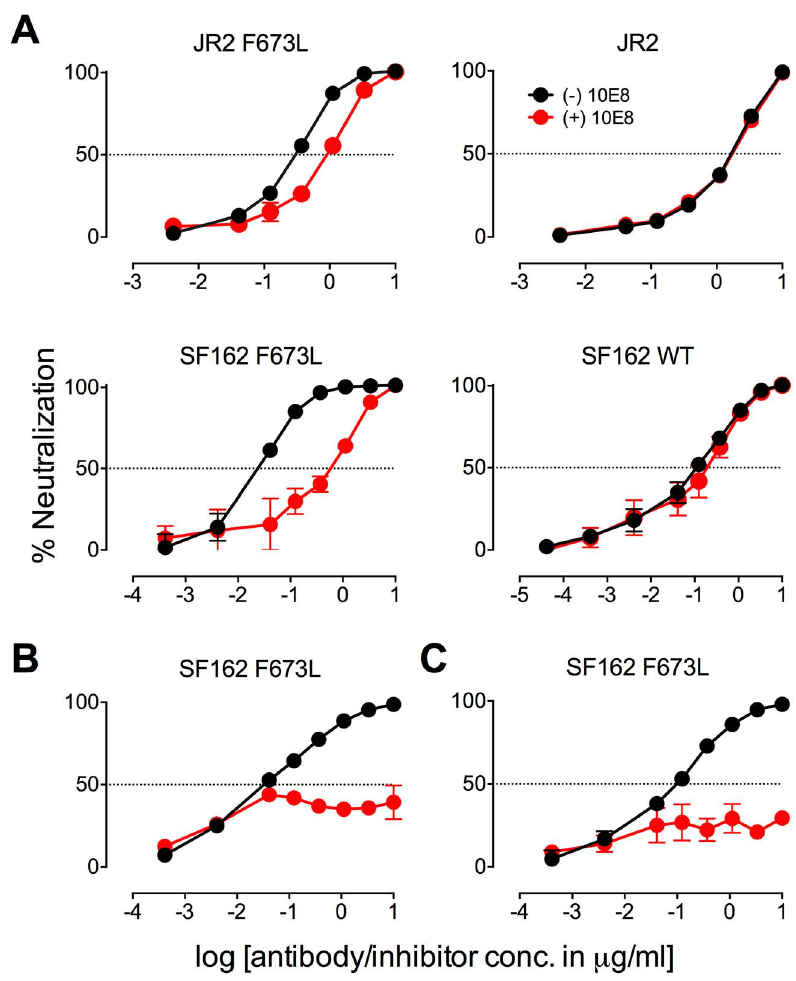
Figure 5. Presence of 10E8 alters sensitivity of HIV-1 to soluble CD4 as well as to antibodies against CD4 and coreceptor binding sites. The presence (red) or absence (black) of 10E8 at 10 m g/ml or the IC 50 for F673L mutants and wild type viruses, respectively, affects the neutralization sensitivity of cognate virus to ( A ) soluble CD4, ( B ) b6 IgG and ( C ) 17b IgG.